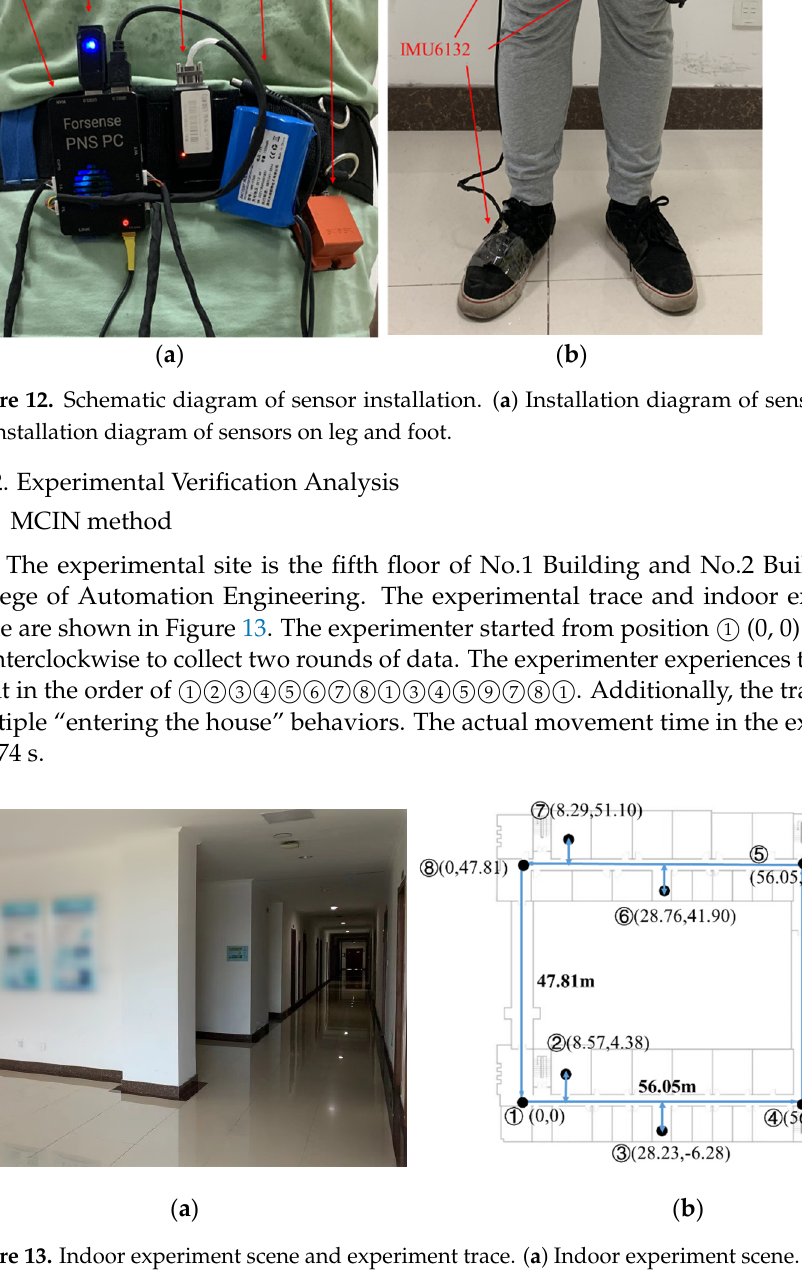
Figure 13. Indoor experiment scene and experiment trace. ( a ) Indoor experiment scene. ( b ) Reference points.